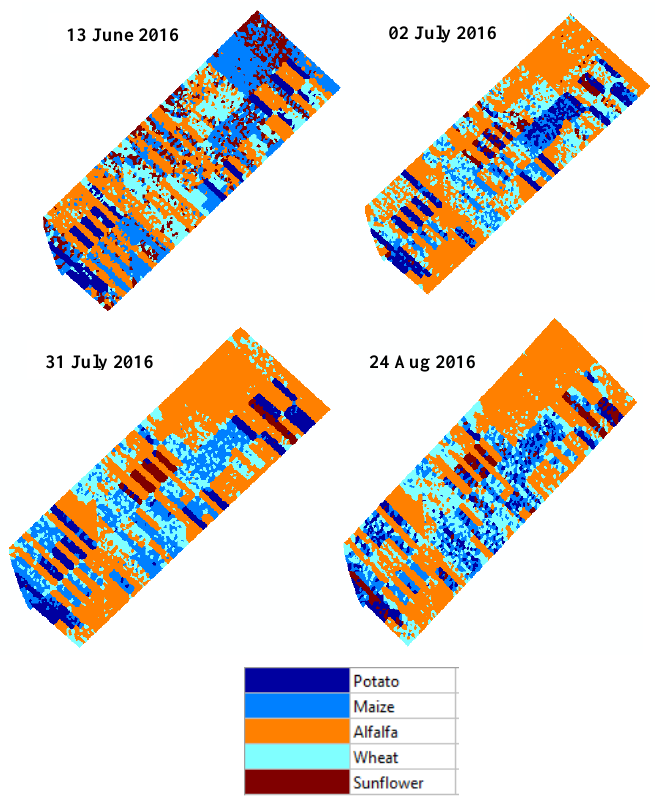
Figure 5. Multi-temporal land use